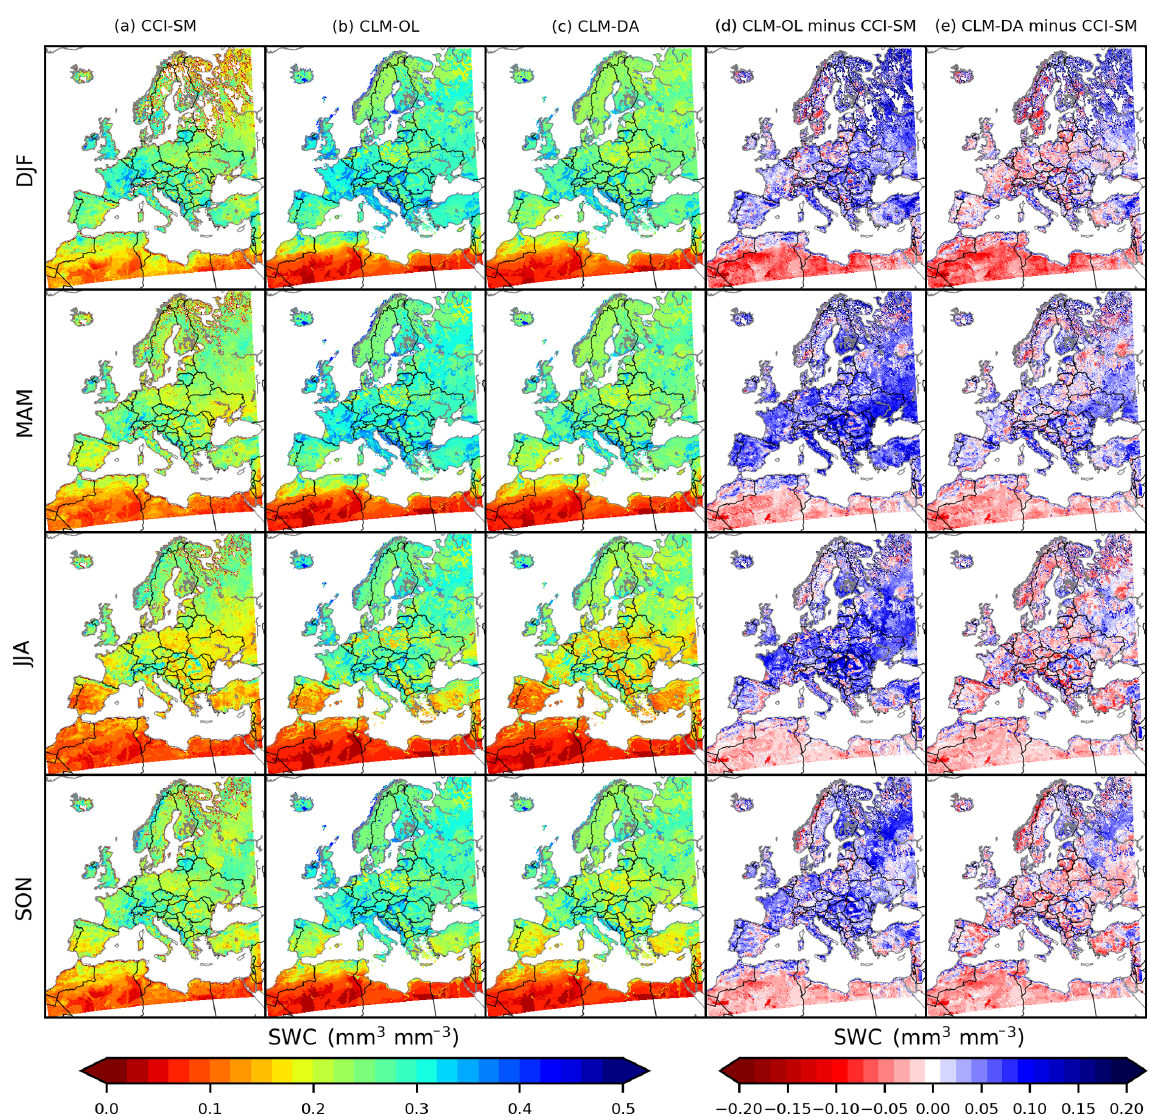
Figure 3. Temporally averaged soil moisture (mm 3 mm − 3 ) content over the 2000–2006 period for (a) CCI-SM, (b) CLM-OL and (c) CLM- DA, and the difference between (d) CLM-OL and CCI-SM and (e) CLM-DA and CCI-SM for DJF (December, January and February), MAM (March, April and May), JJA (June, July and August) and SON (September, October and November)